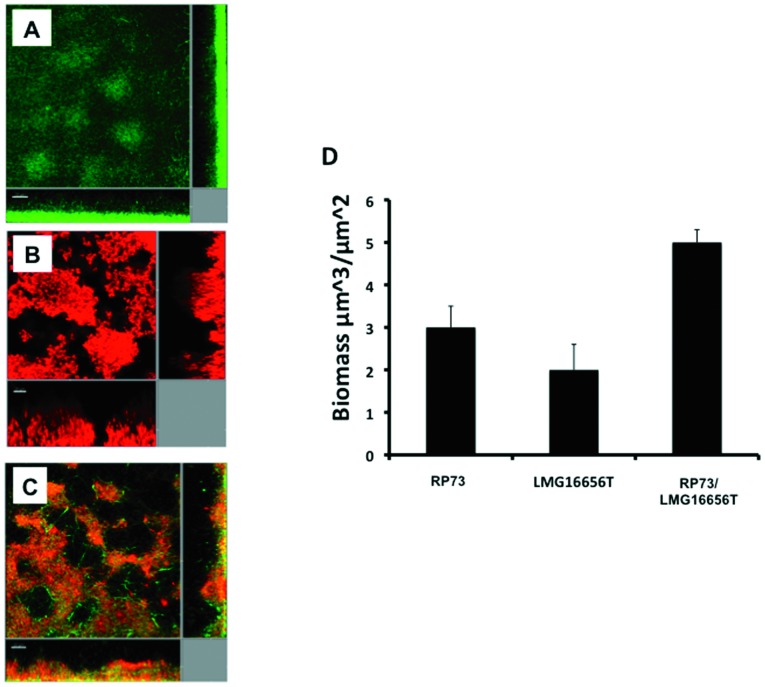
Biofilm architecture in P. aeruginosa is influenced by B. cenocepacia.Images are of 4-day-old biofilms in flow cells in FABL medium. Key: (A) P. aeruginosa RP73; (B) B. cenocepacia LMG16656;(C) mixed culture of P. aeruginosa RP73 and B. cenocepacia LMG16656; (D) Quantification of biomass as determined using COMSTAT to estimate the percentage of P. aeruginosa cells as a function of the total biomass. For these experiments, P. aeruginosa was tagged with mini-Tn7gfp. B. cenocepacia was visualized with Syto62, as described in
Materials and Methods
. Scale bars = 20 µm. Images shown are representative of 12 images from three independent experiments.